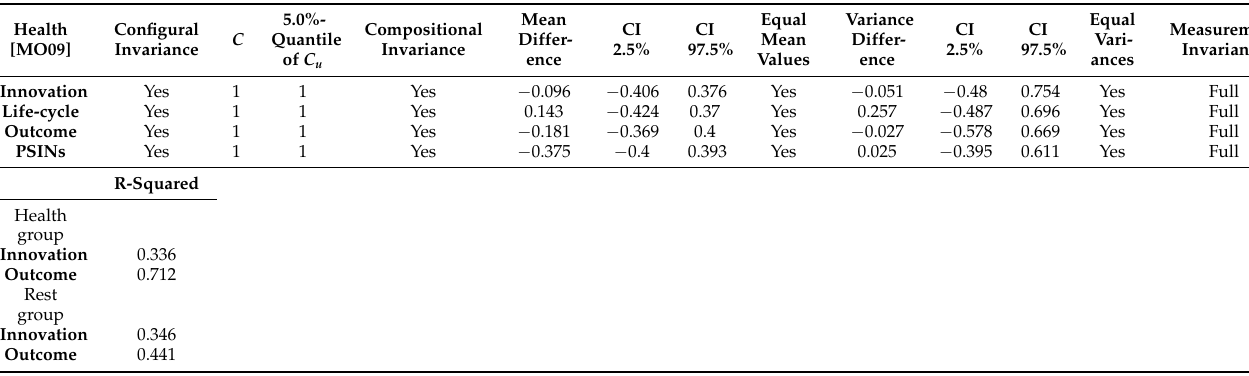
Table A5. Analysis of measurement invariance for the Health sector.